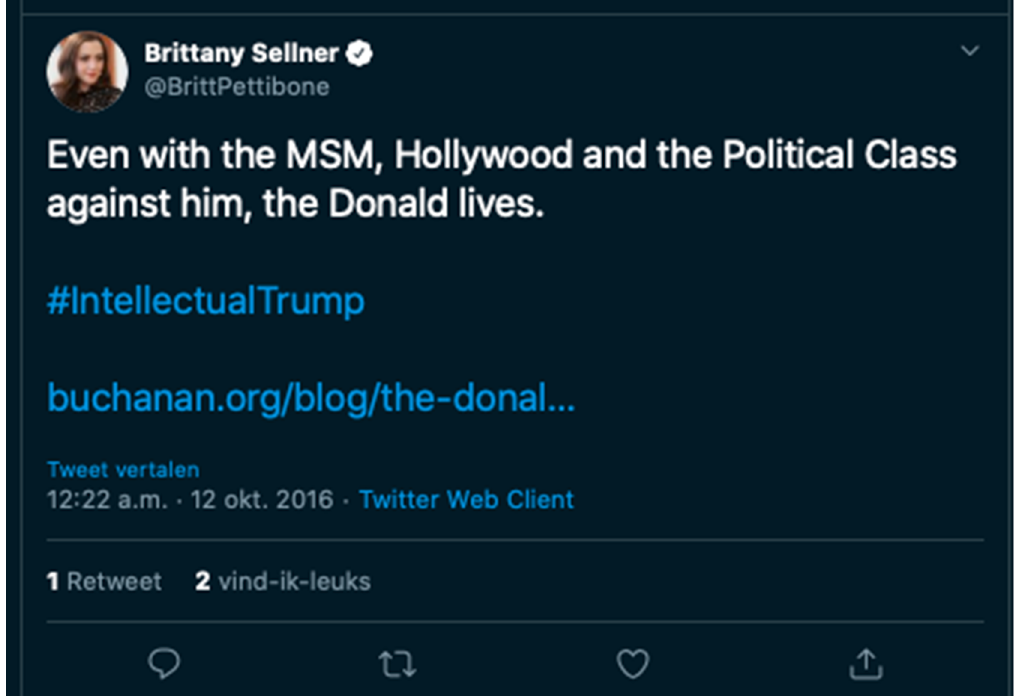
Figure 1. First explicit political tweet from Brittany Pettibone—October 2016.